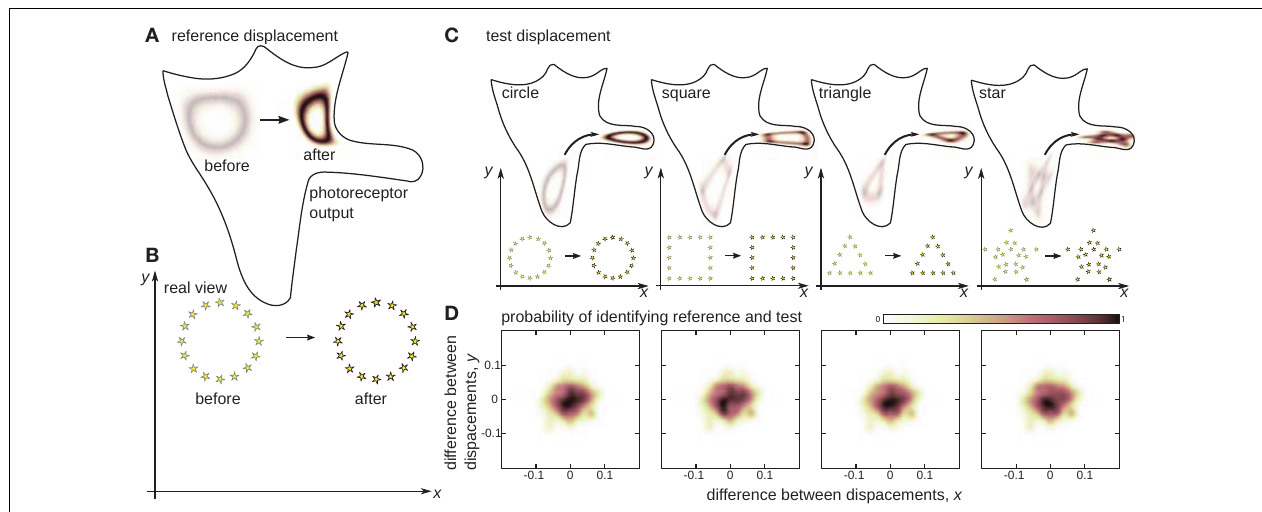
FIGURE 3 | The notion of sensible rigid displacements . Seemingly different changes in sensory input will be associated if they correspond to the same displacement in real physical space. The 2D agent is presented with a reference displacement of the environment (B) , which it scans before and after the displacement. The output of one of the photoreceptors over the unfolded proprioceptive manifold ( Figure 2C ) is presented in (A) . Then the agent is presented with test displacements (C) from different initial positions and for different environments. Even though the test displacements may strongly alter the shape of the reference, the agent succeeds in associating test and reference if they correspond to the same physical displacement (D) . This ability of the agent provides the basis of the notion of displacement independent of the environment.